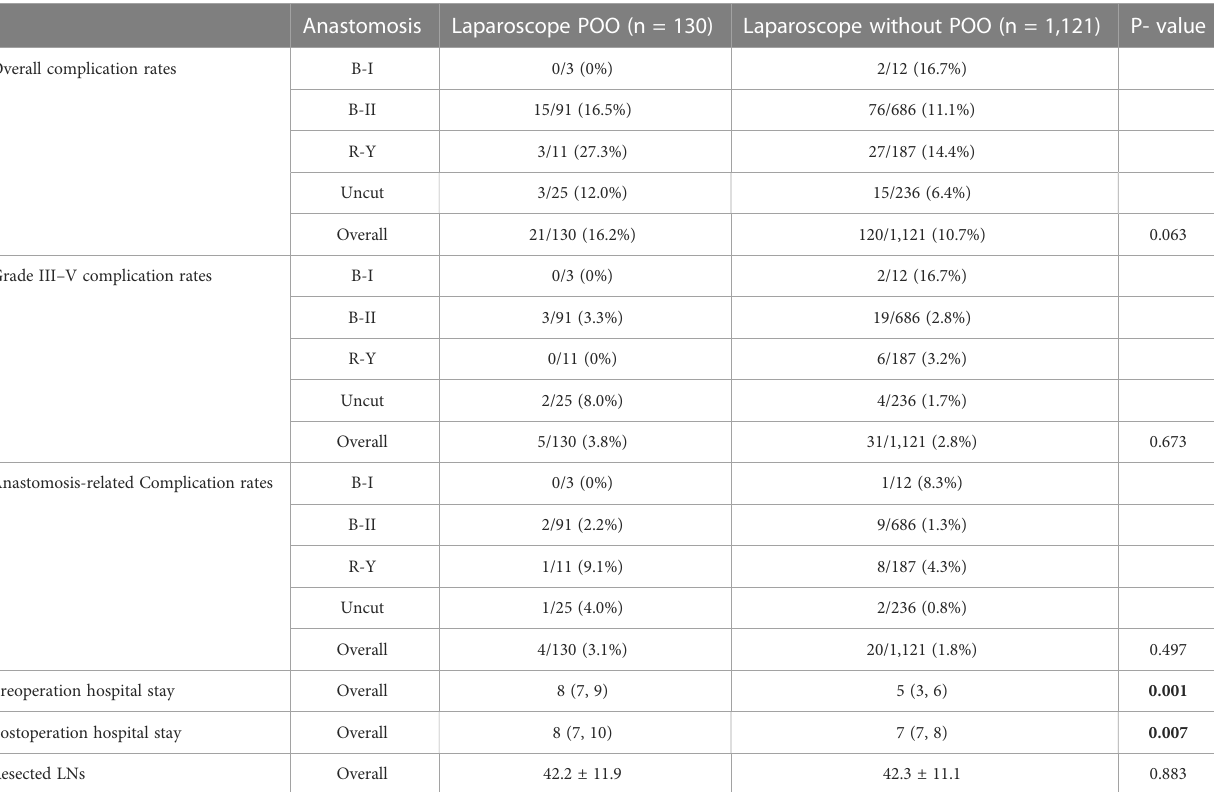
TABLE 2 The information of complication rates, hospital stays, and resected lymph nodes (LNs) between POO and non-POO patients of laparoscopic cases from